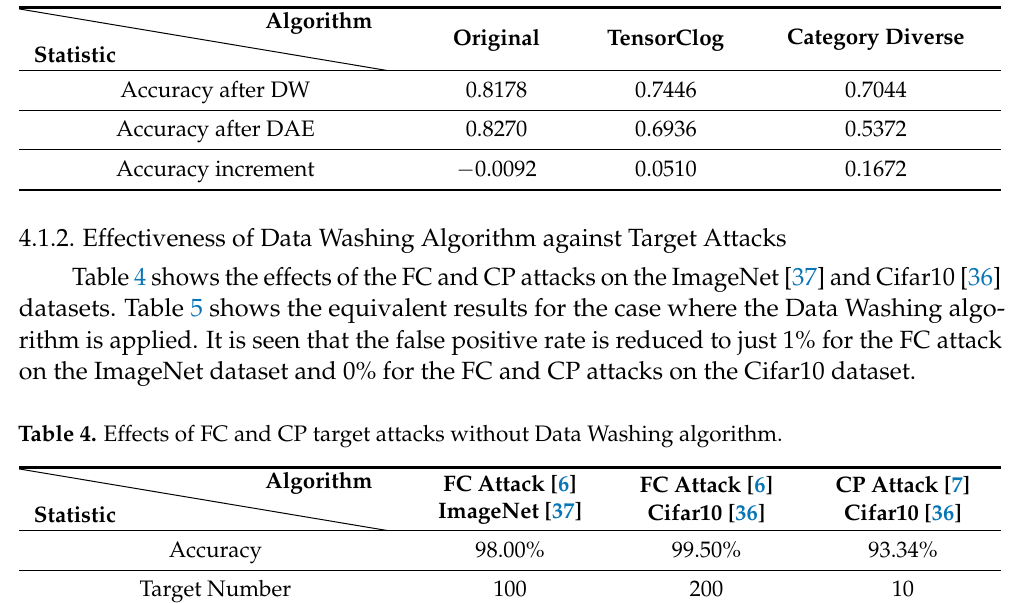
Table 3. Effectiveness of Data Washing algorithm and denoising autoencoder in mitigating effects of paralysis attacks on Resnet18 [10].